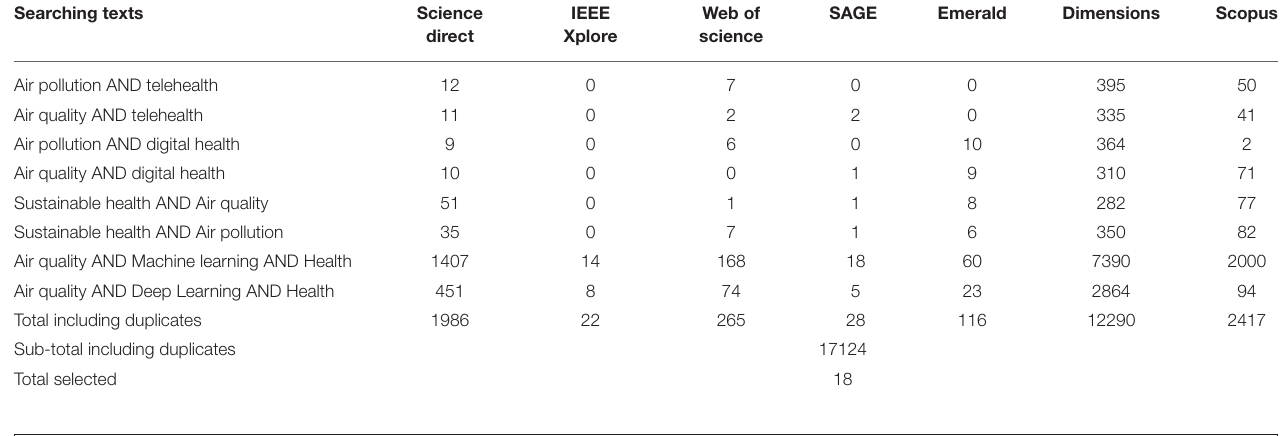
TABLE 3 | Search strings for 7 databases.